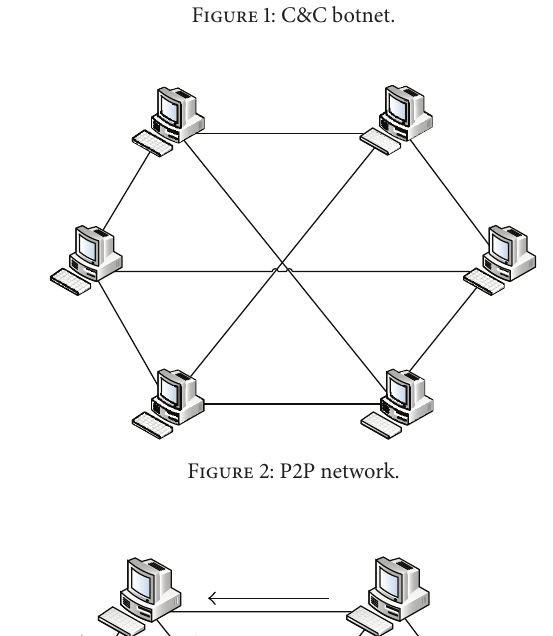
Figure 2: P2P network.